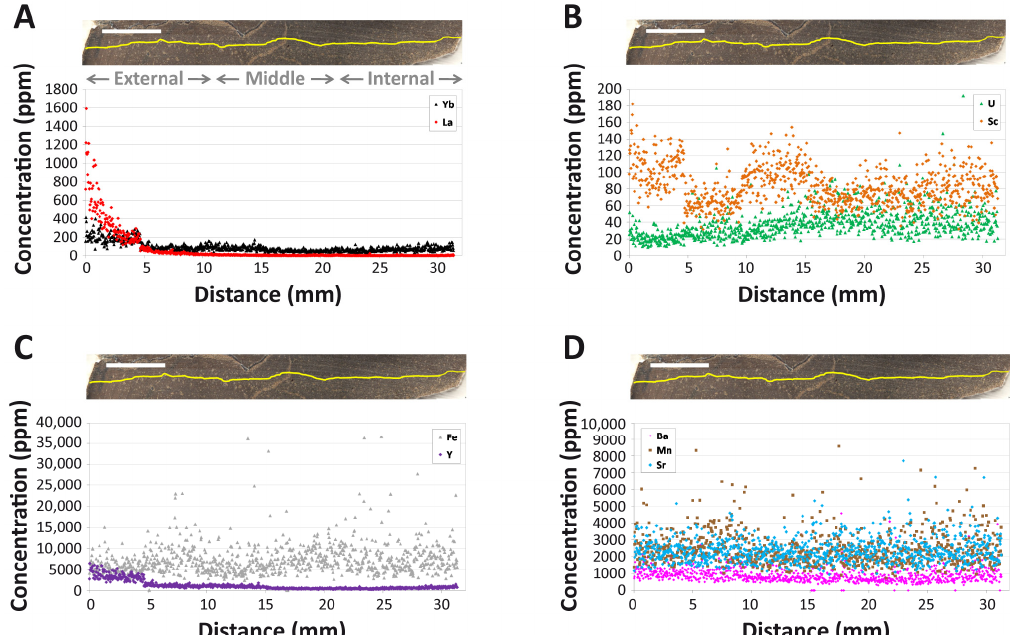
Figure 4. Intra-bone REE concentration gradients of various elements in the femur of MOR 1125. ( A ) Lanthanum (La) and ytterbium (Yb). ( B ) Scandium (Sc) and uranium (U). ( C ) Iron (Fe) and yttrium (Y). ( D ) Barium (Ba), manganese (Mn), and strontium (Sr). Note the different concentration scales for each panel. The laser track is denoted by the yellow line in each bone cross section. Gray text labels in ( A ) span the approximate regions considered as the ‘external’, ‘middle’, and ‘internal’ cortices. Scale bars, in white over bone images, each equal 1